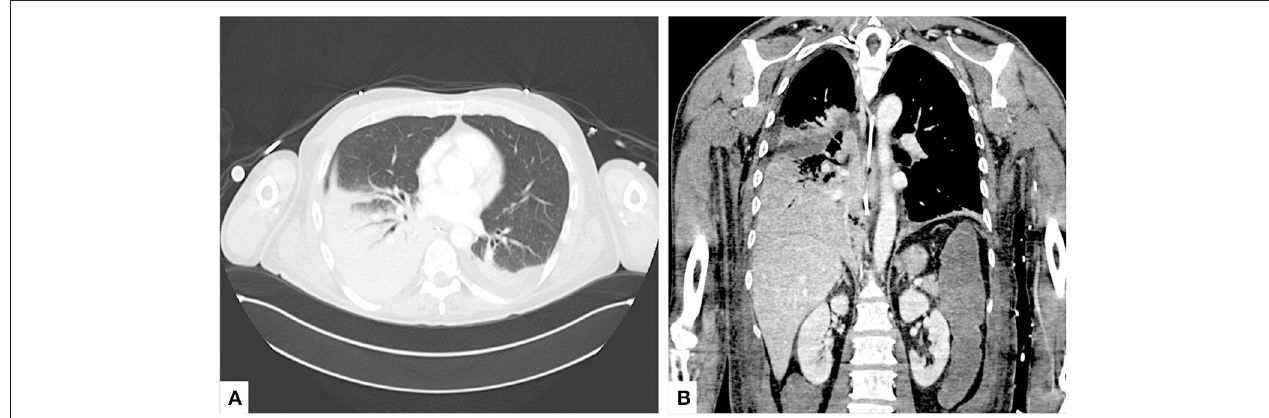
FIGURE 1 | Preoperative CT scan. (A) Axial and (B) coronal views of admission chest CT scans showing mixed ground-glass opacities and consolidation with positive air bronchograms involving both the medium and the lower right lobes.